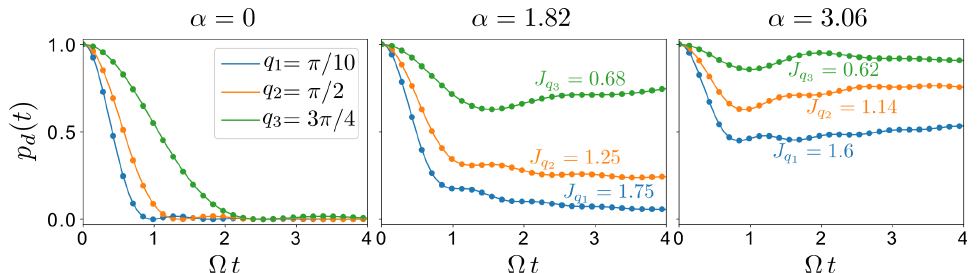
Figure 5: Survival probability of a Rydberg cluster containing a single excitation : The survival probability obtained from the numerical evaluation of Eq. (23) (plotted with dots) is exactly reproduced by the analytical result, Eq. (24), obtained from Fano theory and plotted with full lines. For α = 0 the survival probability decays quickly to zero for all the three considered q values. As α increases, more q -modes acquire a non zero survival probability. This explains the strong inhibition of the spreading of a Rydberg cluster containing a single excitation, as observed in Fig. 3. The parameters chosen for the plots are ω = 8 Ω and κ = { 0, 2.7 Ω , 3.5 Ω }